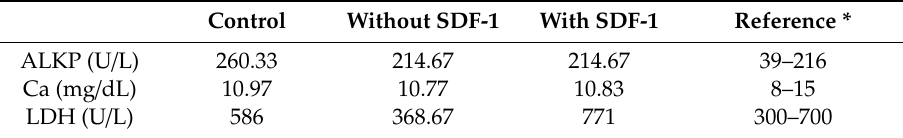
Table 2. Biochemistry test (two months).